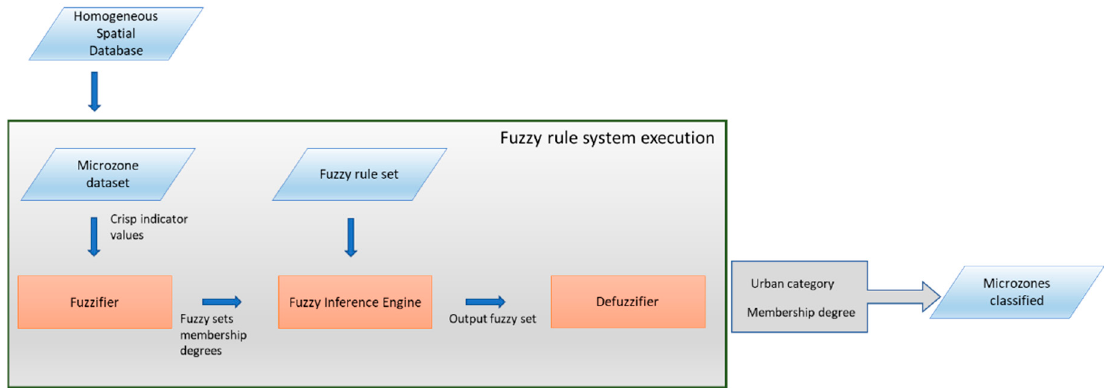
Figure 3. Scheme of the fuzzy rule-based system.